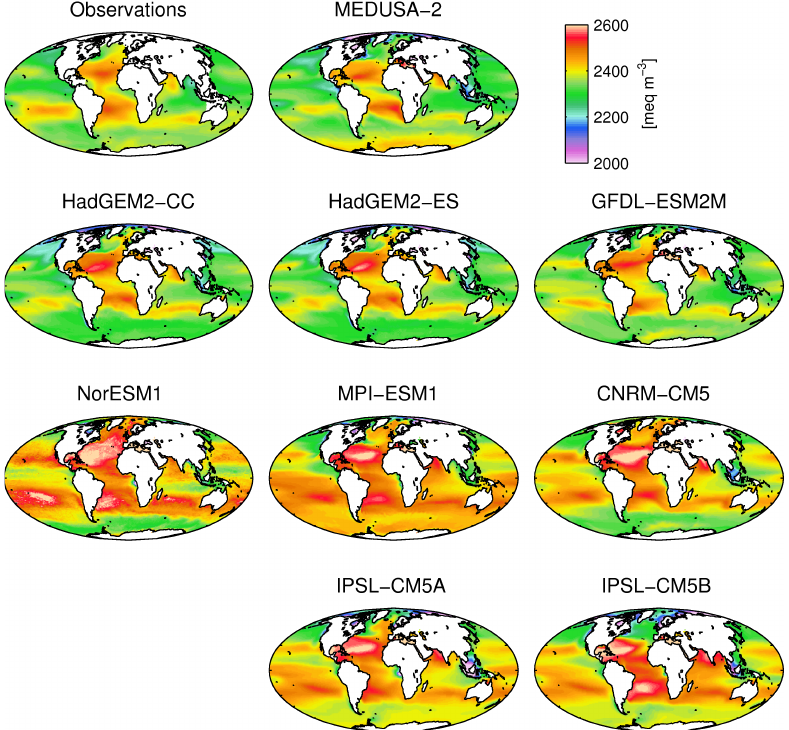
Fig. 47. Intercomparison of annual mean surface alkalinity for M EDUSA -2.0 and a range of comparable CMIP5 models. Surface alkalinity in meqm − 3